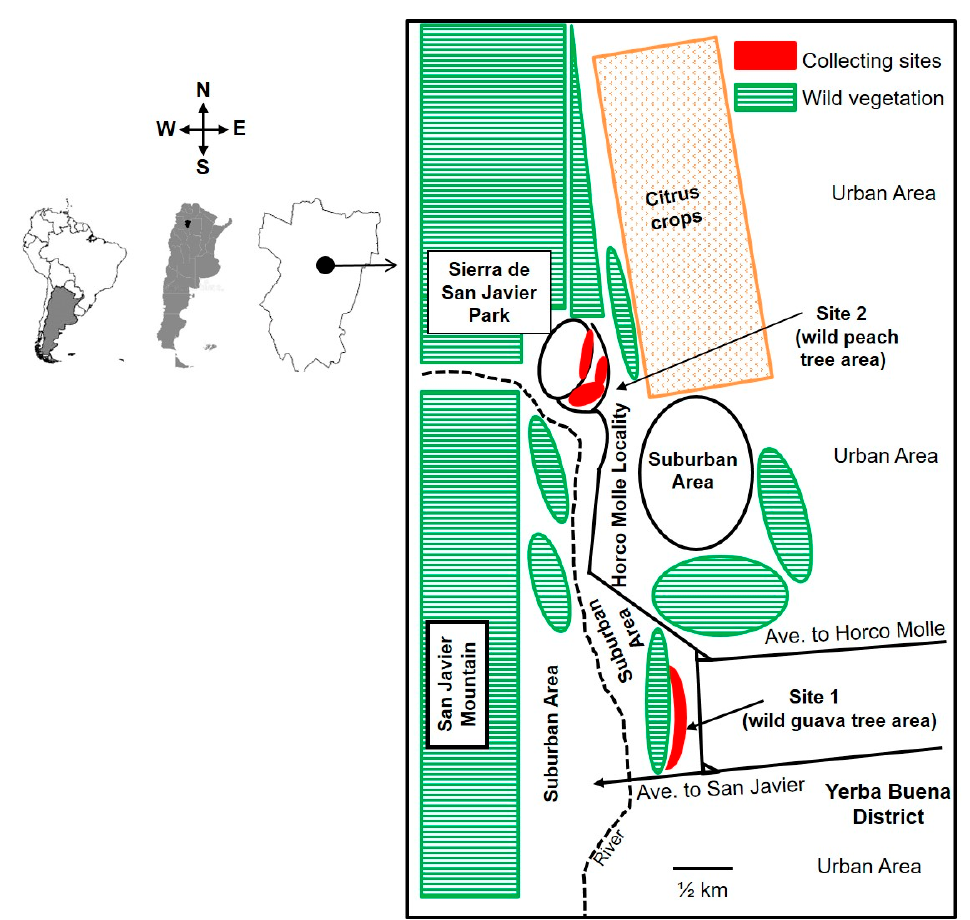
Figure 1. Study area showing the two sampling sites: Site 1, a guava tree-dominated habitat; Site 2, a peach tree-dominated habitat. The area is located in Horco Molle, Yerba Buena district, Tucumán province, northwestern Argentina.